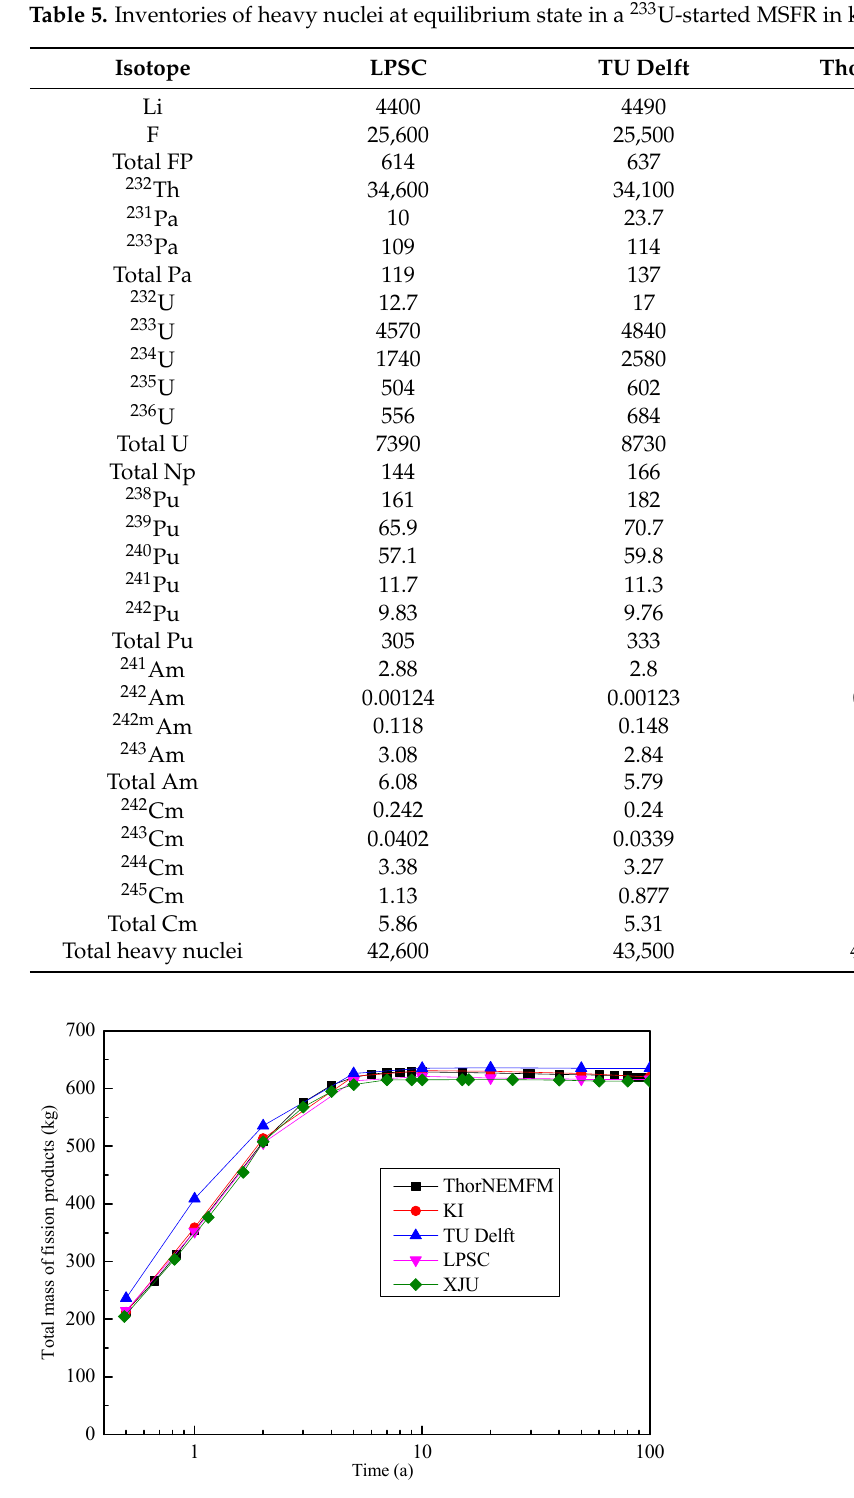
Figure 7. Total mass of FPs in the 233 U-started MSFR as a function of time.